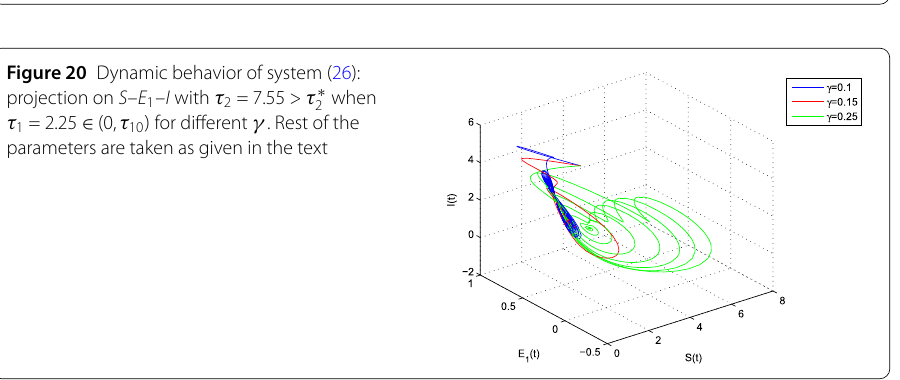
Figure 19 Time plots of S , E 1 , E 2 and I for different γ at τ 2 = 6.25 when τ 1 = 2.25 ∈ (0, τ 10 ). Rest of the parameters are taken as given in the text